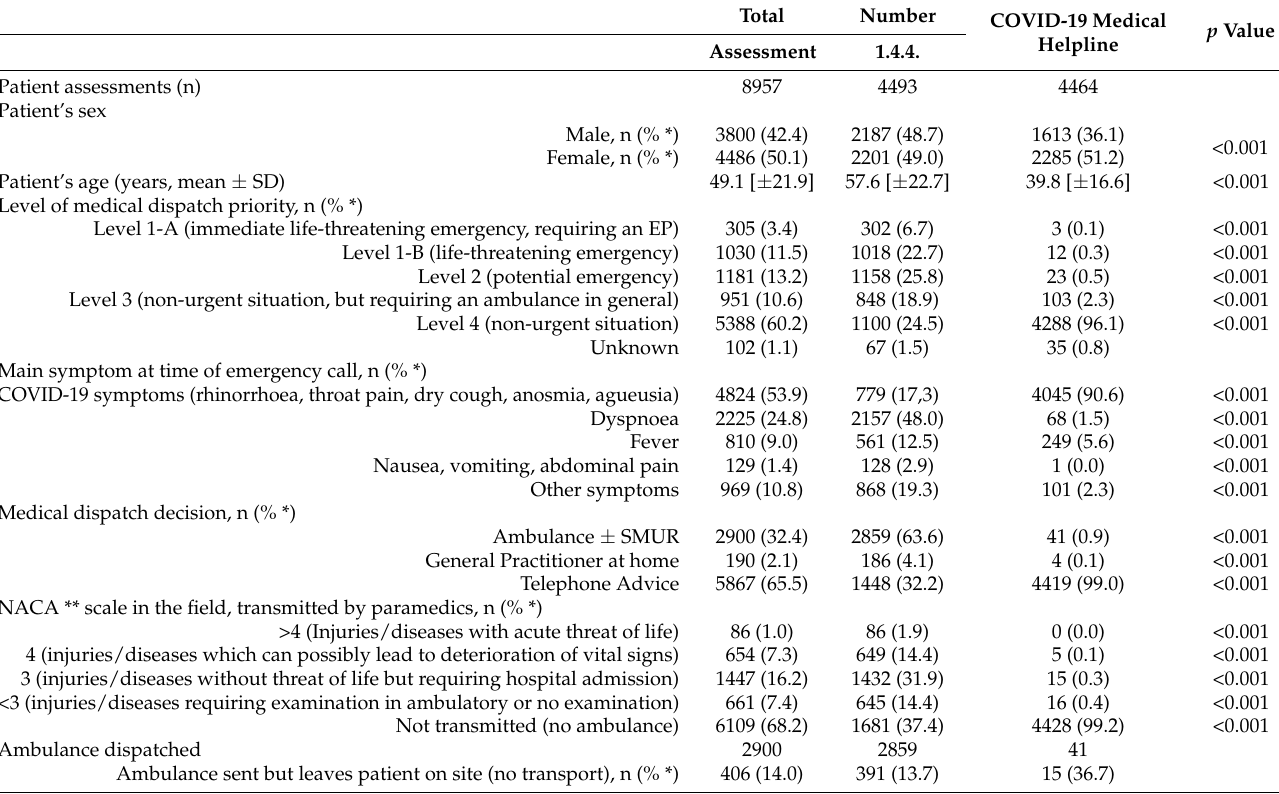
Table 1. Characteristics of patients with suspected or confirmed COVID-19 infection assessed at Geneva’s